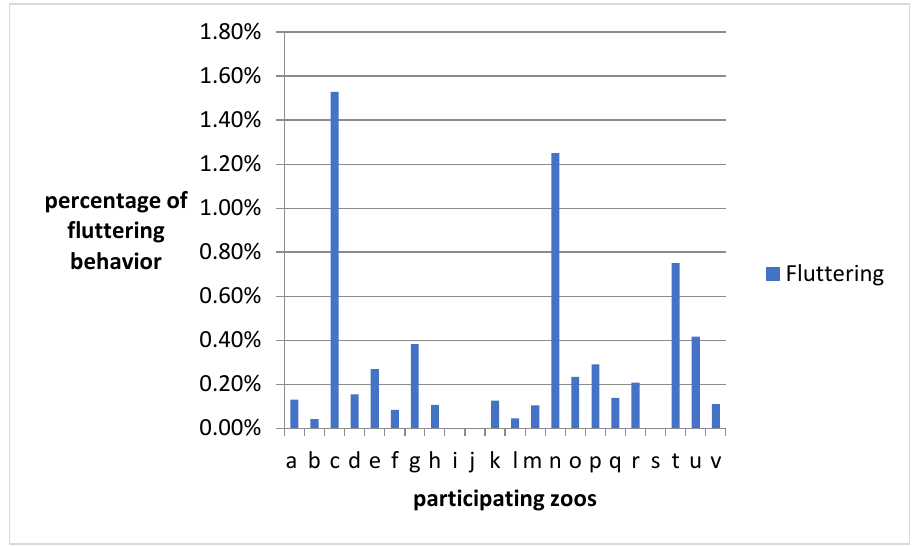
Figure 3. The percentage of fluttering at the different zoos.